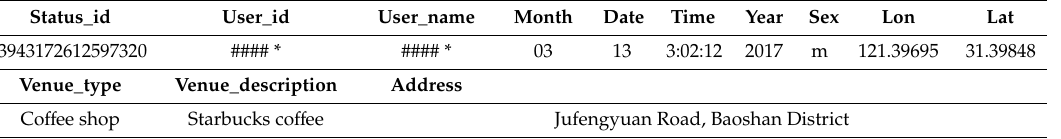
Table 1. Example of Weibo check-in.